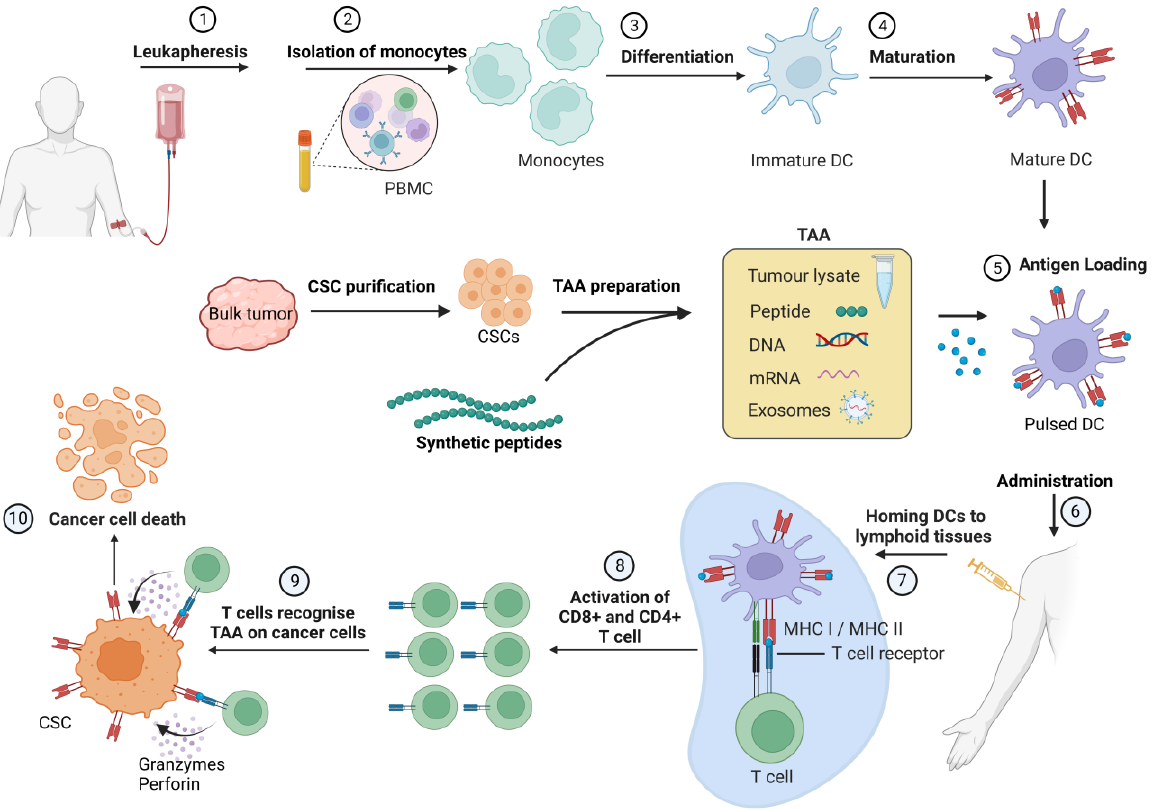
Figure 3. Development of the DC autologous vaccines. The DC vaccines are most commonly pre- pared by ex vivo differentiation of the autologous monocytes into immature DCs. After matura- tion, DCs are pulsed with cancer antigens and administered back to the patient, where they activate antigen-specific T cells. CSC — cancer stem cells; MHC I and MHC II — major histocompatibility specific T cells. CSC—cancer stem cells; MHC I and MHC II—major histocompatibility complex complex class I and class II; PBMC — peripheral blood mononuclear cells; TAA — tumor-associated antigen. Created with BioRender.